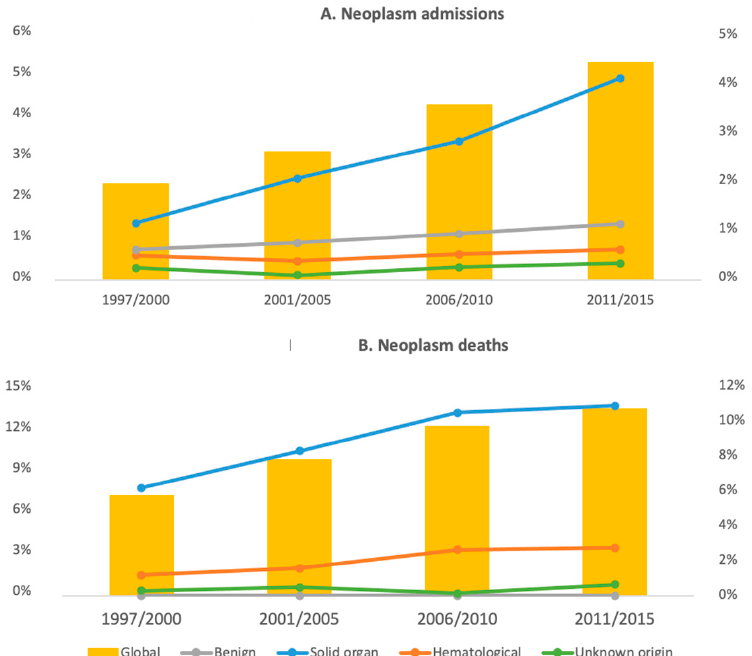
Figure 3. Neoplasm admissions and deaths. The figure shows the trends in admissions ( A ) and deaths ( B ) because of neoplasm. Data are expressed as a percentage of total admissions and deaths for the overall neoplasms (left ordered axis) and for the benign, solid organ, hematological and unknown origin neoplasm (ordered axis).